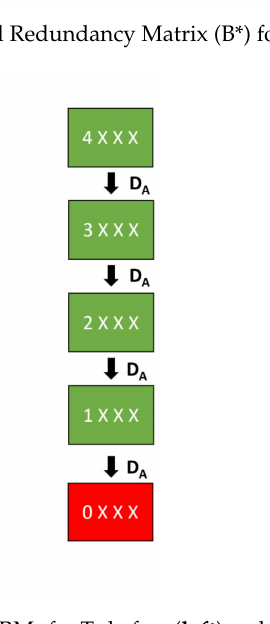
Figure 22. Static TBRMs for T 1 before ( left ) and after ( right ) Intelligence Transfer showing the creation of a new acceptable state in the MAS’ fault tolerance